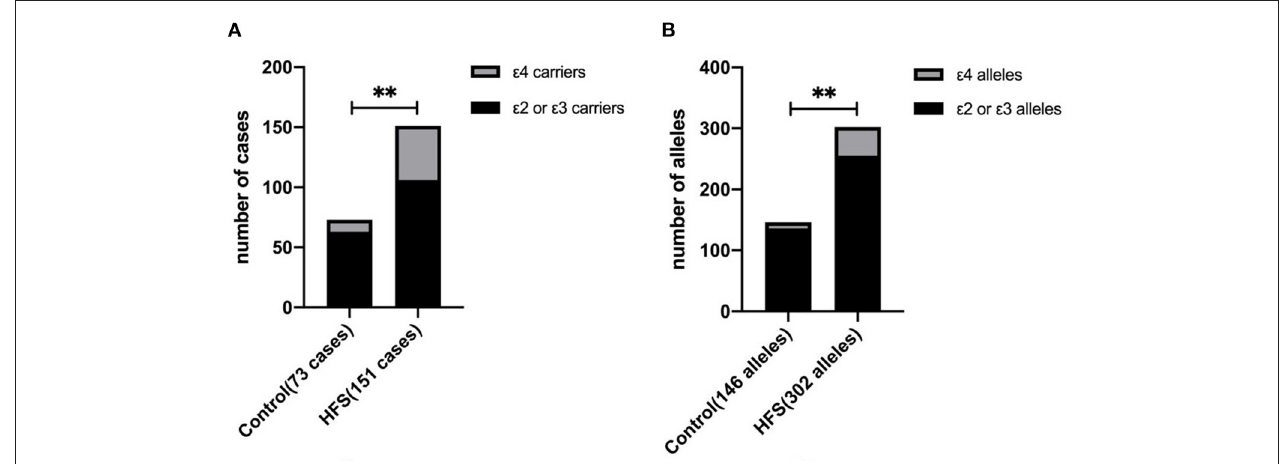
FIGURE 1 | The difference between the hemifacial spasm group and the control group in the ε 4 allele frequency and the ε 4 allele carrier. The proportion of ε 4 allele carriers in the hemifacial spasm group was higher than that in the control group (A) . The ε 4 allele frequency in the hemifacial spasm group was higher than that in the control group (B) . ( ** : P < 0.001).